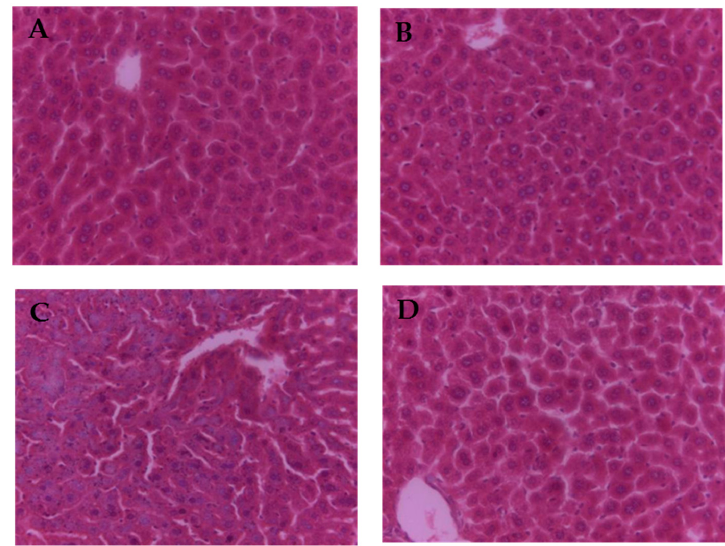
Figure 1. Pretreatment effects of GSPE on ZEN-induced liver histopathological changes in mice (original magnification of ×400). ( A ) control group; ( B ) GSPE group; ( C ) group administrated with ZEN at a dose of 40 mg/kg; ( D ) pre-administrated with GSPE at a dose of 100 mg/kg treatment group.